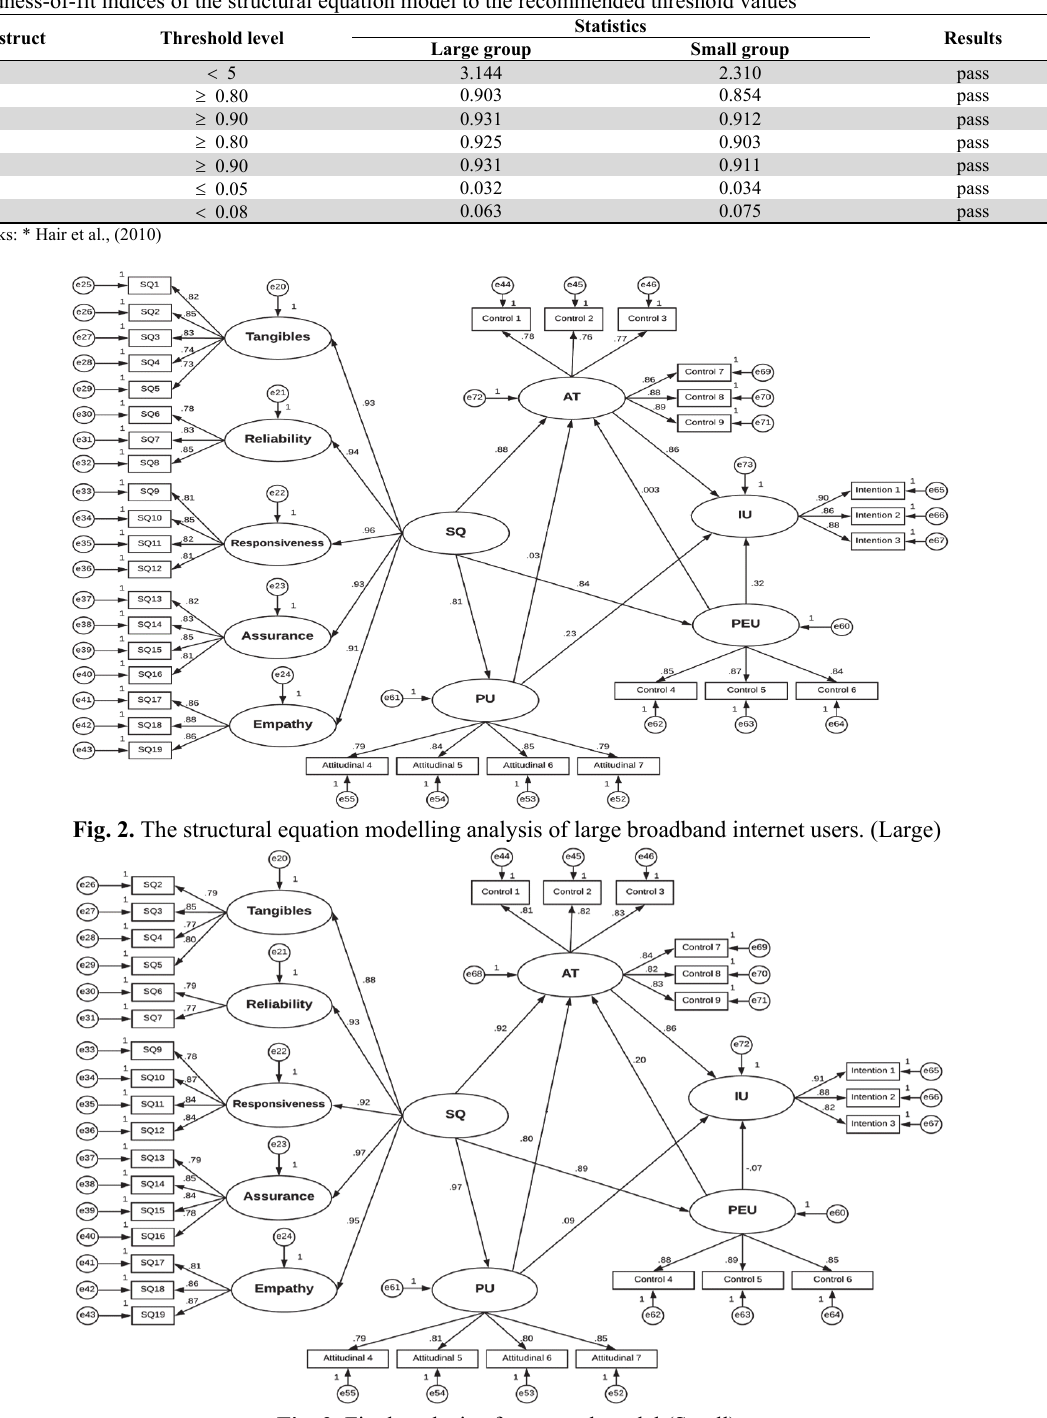
Fig. 3. Final analysis of structural model